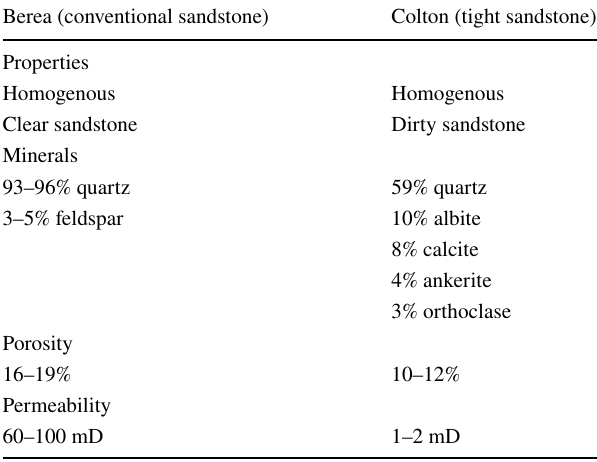
Table 2 Characteristics of core samples used in core flooding experi- ments Berea (conventional sandstone)